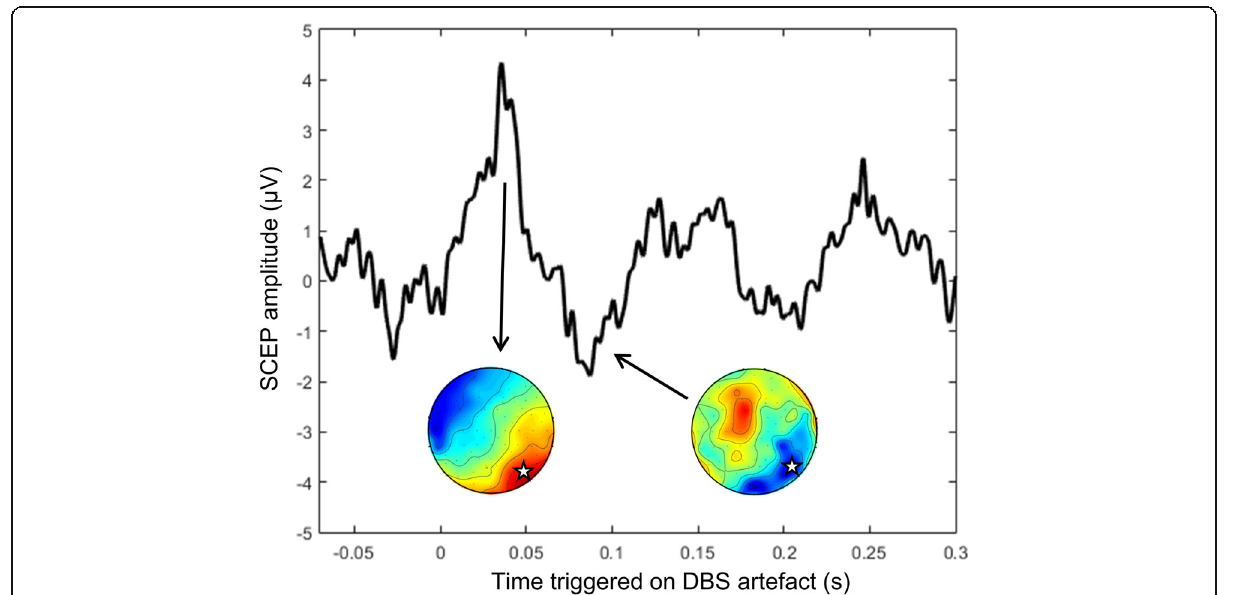
Fig. 2 SCEP on a right occipital electrode in a PD patient stimulated in the left STN at 3 Hz. Topographical EEG plots show the two main components of the SCEPs. The white star indicates the position of the electrode used to compute the SCEP. Kibleur et al., unpublished